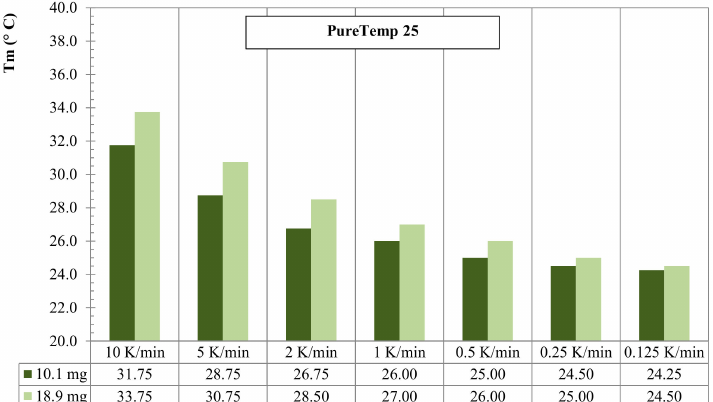
Figure 9. Melting peak temperature T m for dynamic DSC measurements with several heating rates and 2 di ff erent masses for RT25.